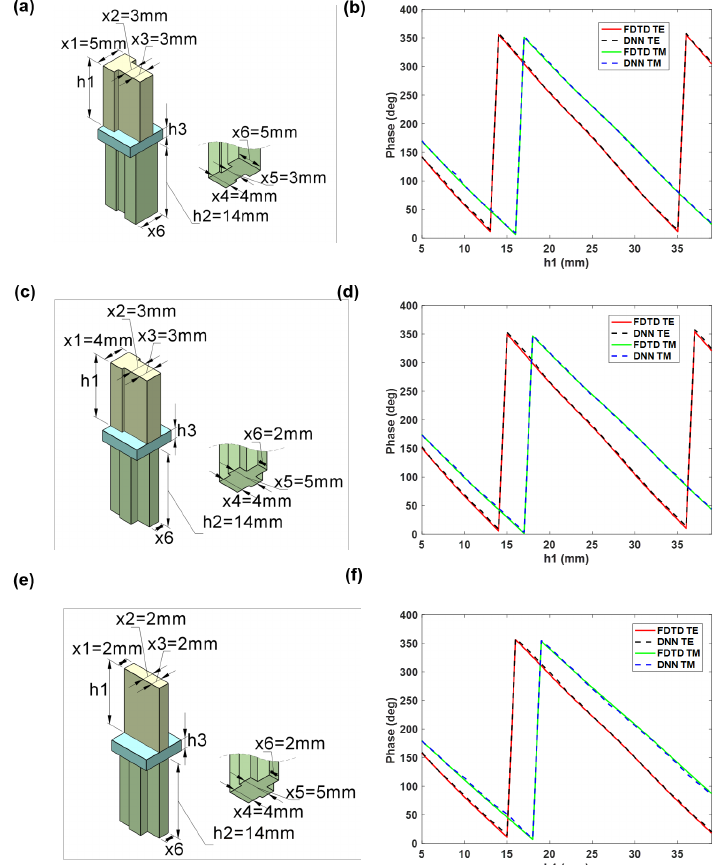
Figure 3. Neural network prediction results comparison chart. (a), (c), (e) Structure of unit cell chosen at random. (b), (d), (f) Comparison results of Algorithm-Based calculation and prediction results.